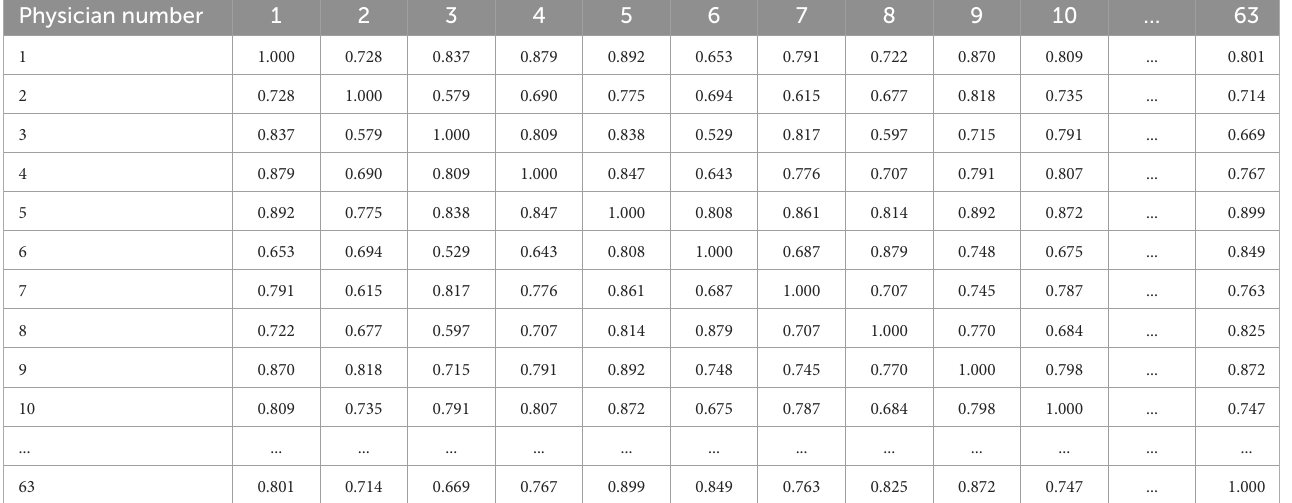
TABLE 11 The cosine similarity of